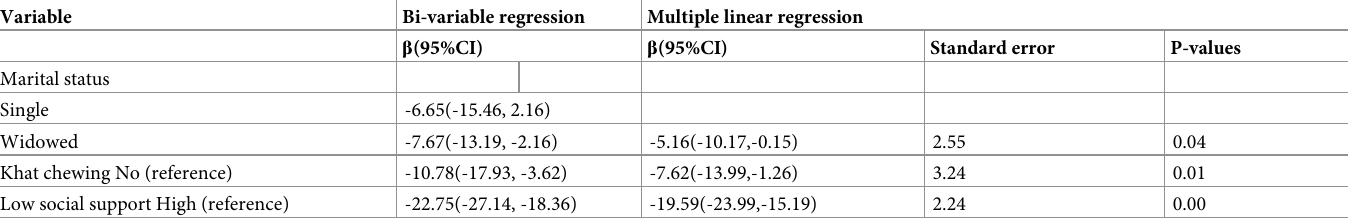
Table 6. Multivariable linear regression model on factors associated with psychological domain of HRQoL among adult hypertensive patients on treatment at pub- lic health facilities in Dessie City Administration, Northeast Ethiopia, 2021 (n = 360).